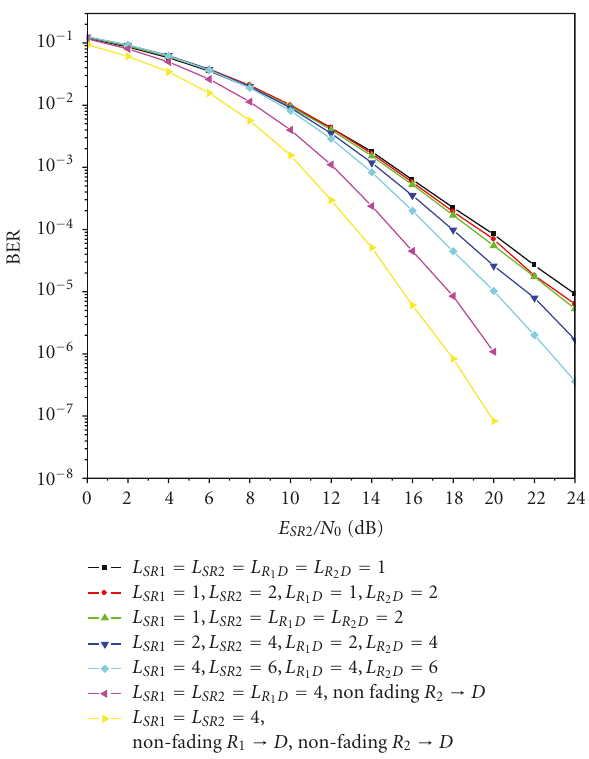
Figure 2: BER performance of DSTBC with FD-LE for various combinations of channel memory orders.